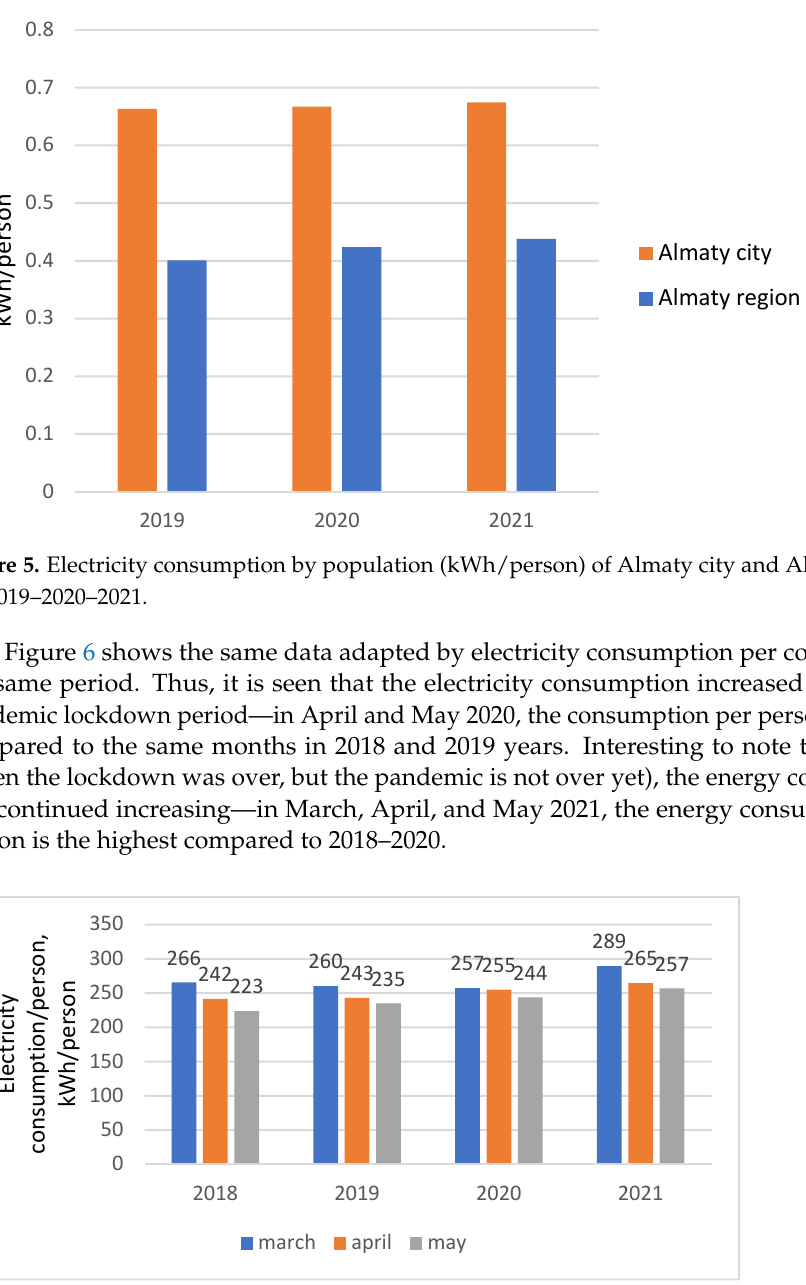
Figure 6. Electricity consumption per consumer (kWh/person) in Atyrau for 2018–2021 years.